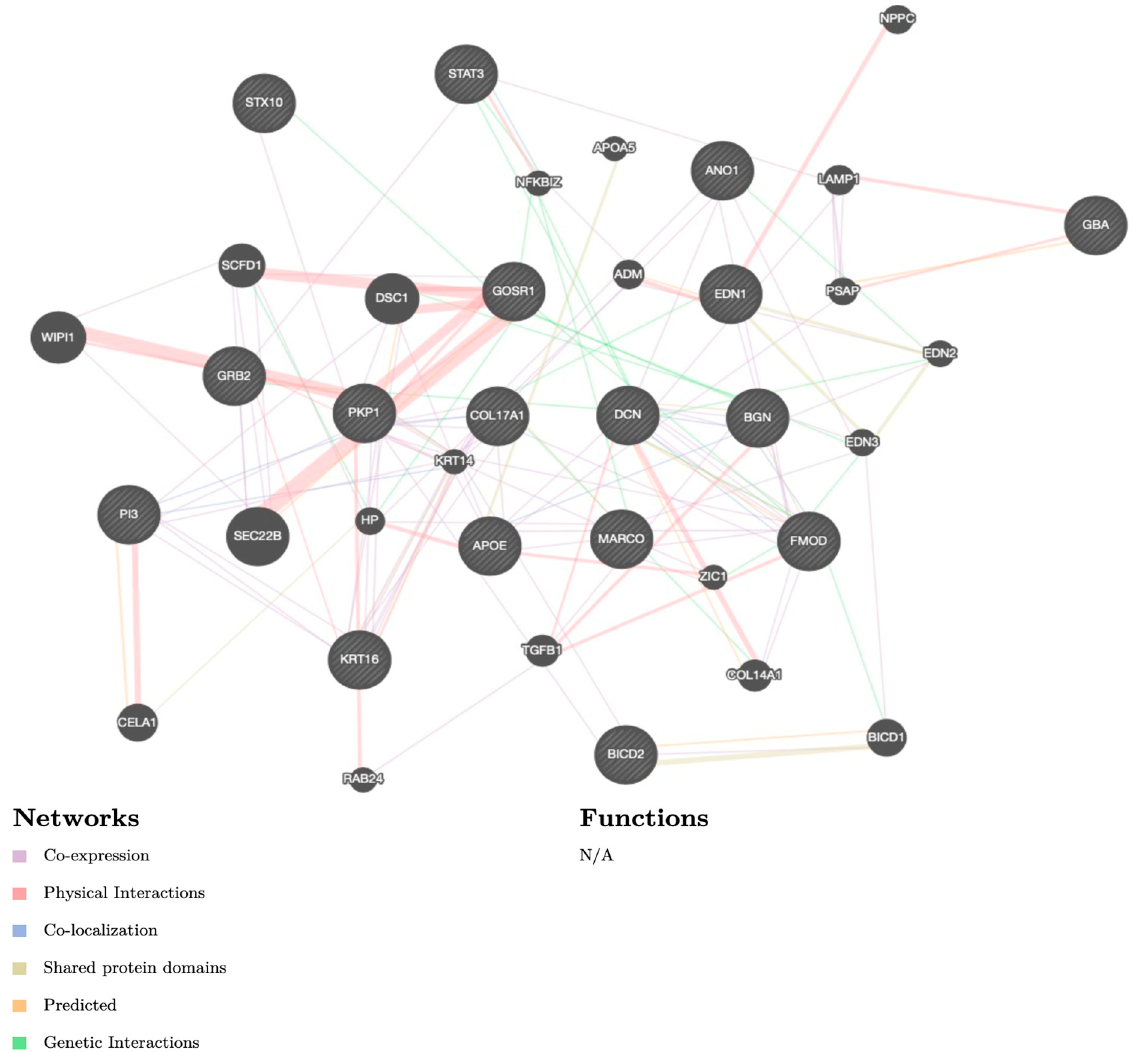
Figure 2. GeneMania software diagram. The color of the line attaching the genes explains the kind of interaction: co-expression in purple lines, physical interactions in red lines, co-localization in blue lines, shared protein domains in bright yellow lines, predicted communication in orange color, and genetic interactions in green lines. Note: N/A—not available.